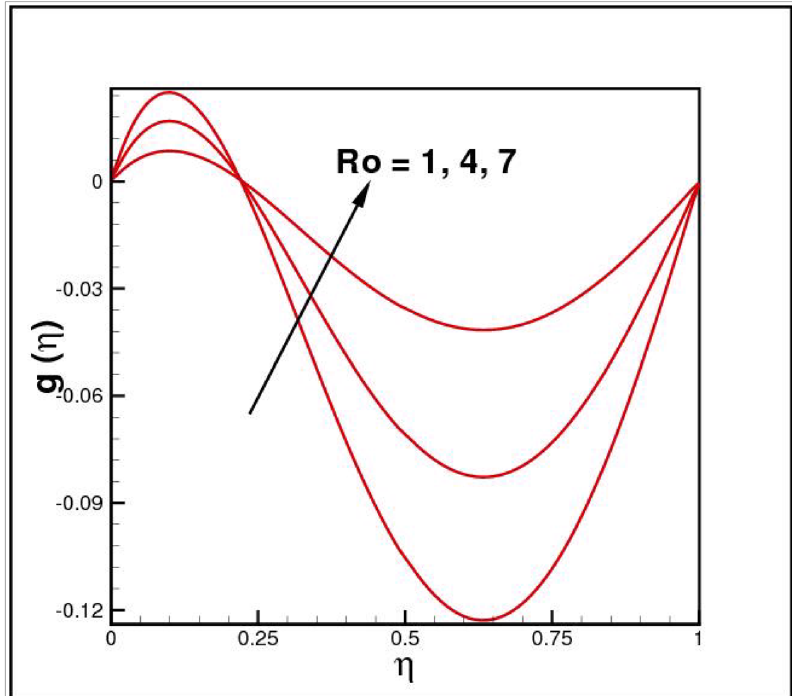
Figure 5. Impact of Ro on g ( η ).